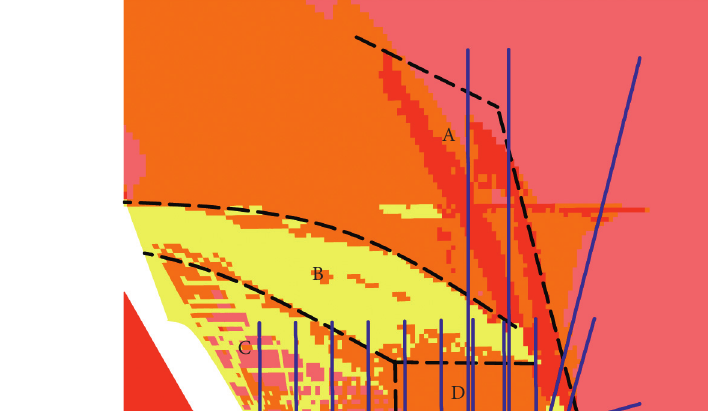
Figure 10: Axial force distribution of roof bolt.